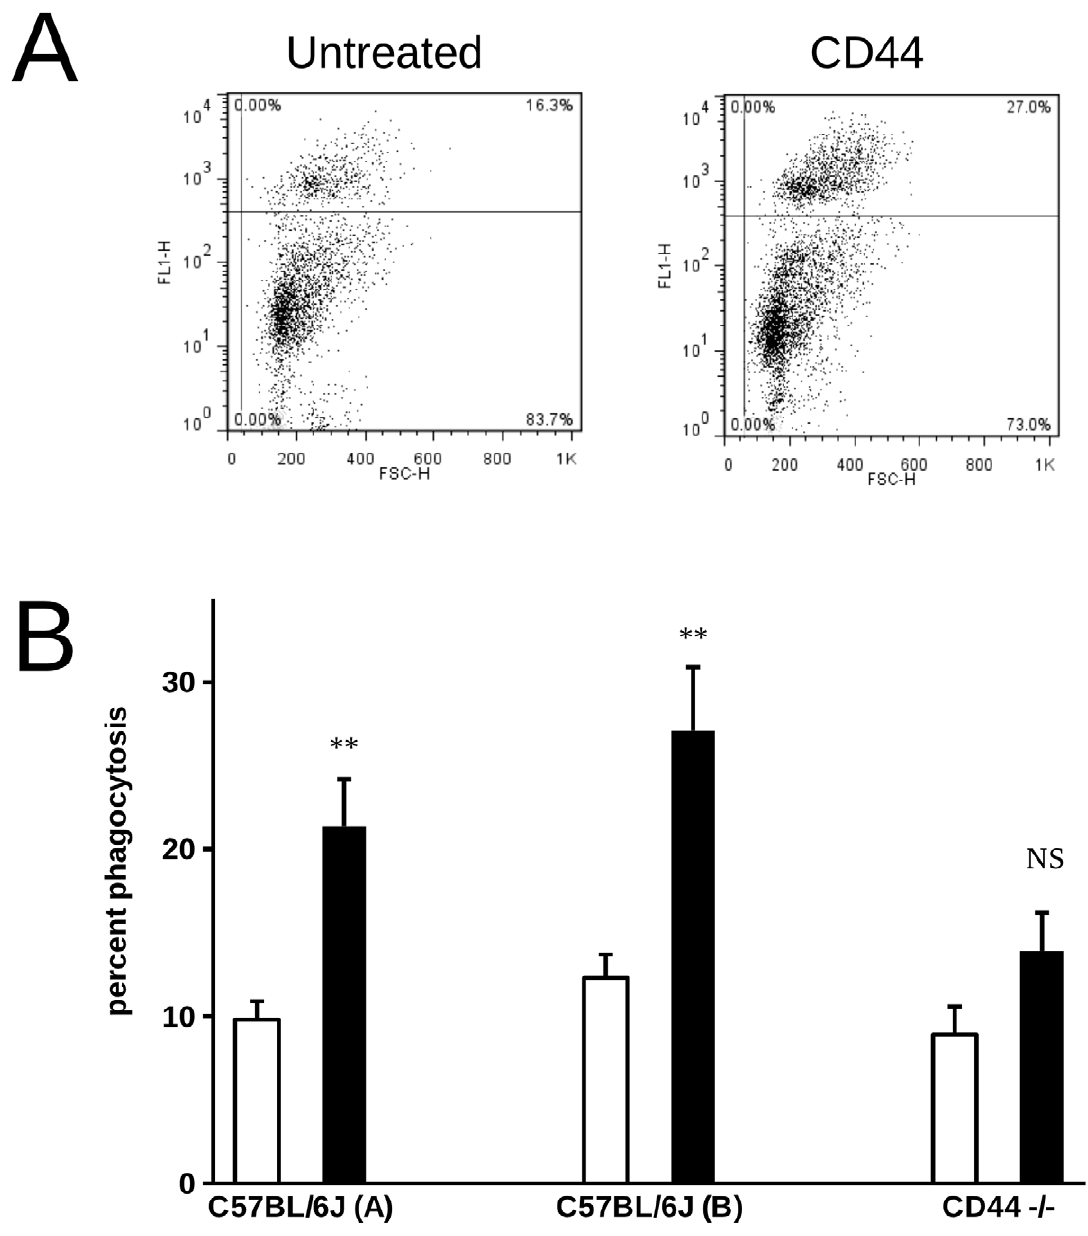
Figure 8. Effects of CD44 cross-linking on phagocytosis of human apoptotic PMN transfered into the peritoneal cavity of mice. A) CMFDA-labelled human apoptotic neutrophils were transferred into the peritoneal cavity of mice that had been previously injected with CD44 mAb, 8D2 or mouse IgG1 control antibody. Phagocytosis of apoptotic cells was determined by flow cytometry following labelling of mouse macrophages with PE-conjugated F4/80. Representative histograms show Forward Scatter versus FL-1 for IgG1 treated versus 8D2 treated animals – representative of 4 independent experiments that were performed. B) Wild-type (C57BL/6J) or CD44 2 / 2 mice were pre-injected with either IgG1 (white bars) or CD44 mAb (8D2 – black bars) into the peritoneal cavity prior to injection of human apoptotic neutrophils. Quantification of phagocytosis by peritoneal macrophages lavaged from either wild type (C57BL/6J) or CD44 2 / 2 was made by flow cytometry as described for (A) above. For C57BL/ 6J (A) results shown are the mean 6 SEM for 10 separate animals. For C57BL/6J (B) and CD44 2 / 2 , results are from 4 independent experiments. ** indicates results are statistically significant (p , 0.01).